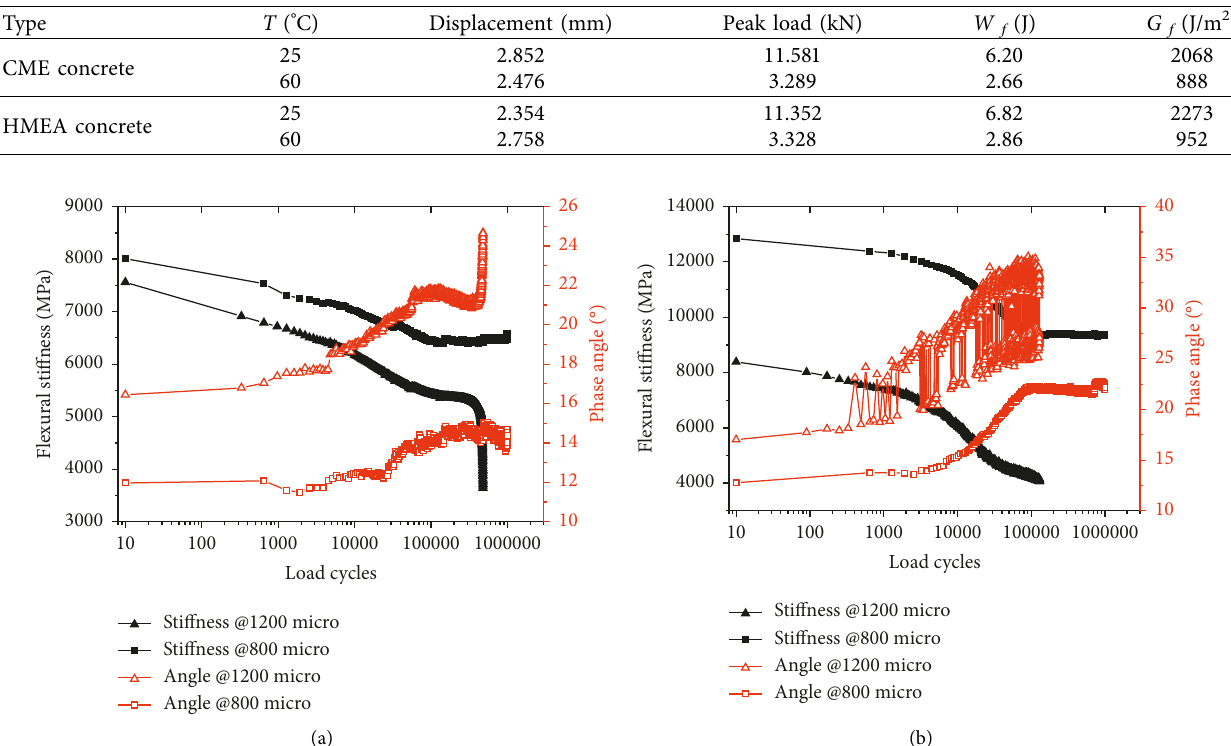
Figure 11: Failure states of (a) CME concrete @25 ° C, (b) HEMA concrete @25 ° C, (c) CME concrete @60 ° C, and (d) HEMA concrete @60 ° C after SCB test. Table 15: Parameters determined from semicircular bending test.